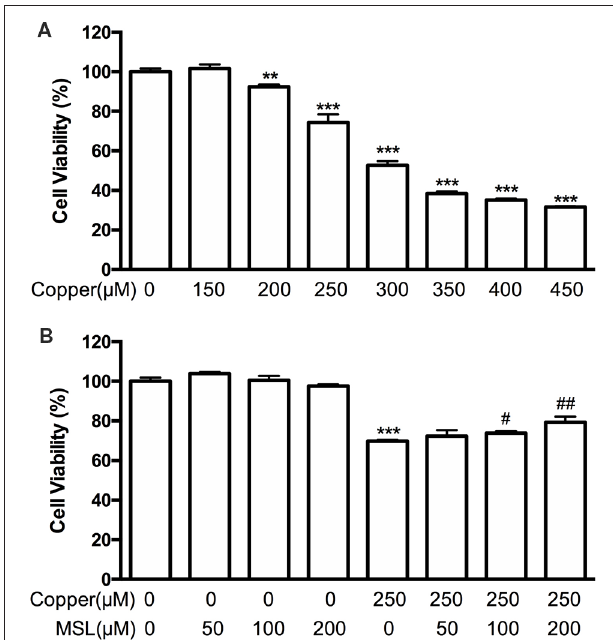
FIGURE 3 | Effects of MSL treatment on the viability of APPsw cells in the presence of copper. (A) Cell viability was assessed by MTS assay in the presence of copper. (B) MSL prevented the damage of APPsw by copper. Data are expressed as the mean ± SEM from three independent experiments. ∗∗ p < 0.01, ∗∗∗ p < 0.001 vs. untreated cells; # p < 0.05, ## p < 0.01 vs. copper-treated